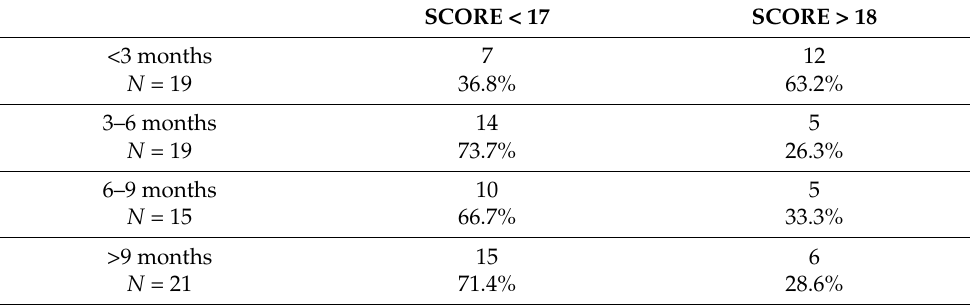
Table 4. Rintala results.